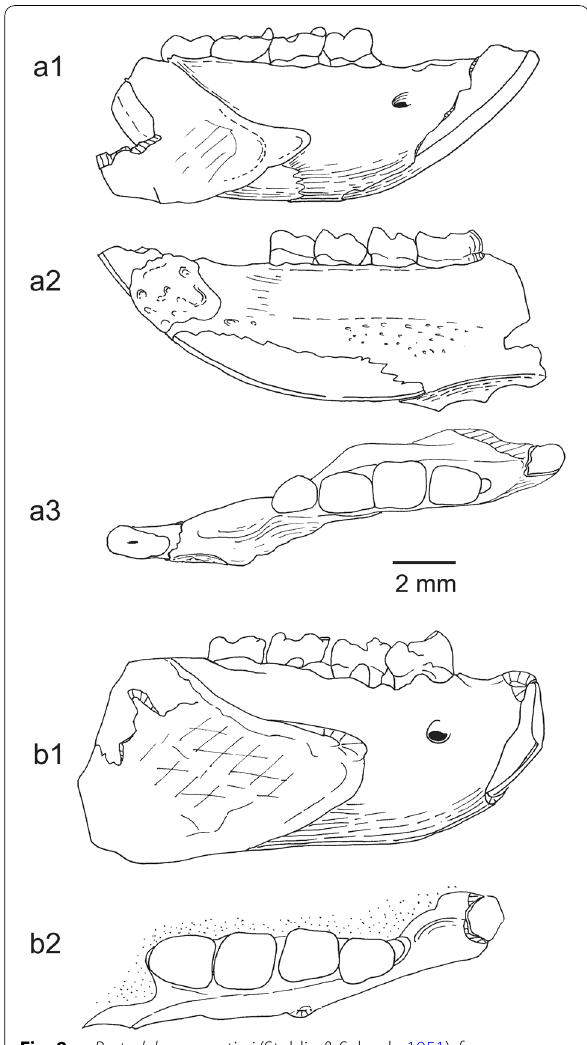
Fig. 8 a: Protadelomys cartieri (Stehlin & Schaub, 1951), from Egerkingen (Swiss Jura); Ek 587, right lower jaw; a1 , labial side; a2 , lingual side; a3 : occlusal view.. b Protadelomys lugdunensis Hartenberger, 1969, from Egerkingen (Swiss Jura); Em 21, right lower jaw; a1, labial side; a2, occlusal view. Scale bar